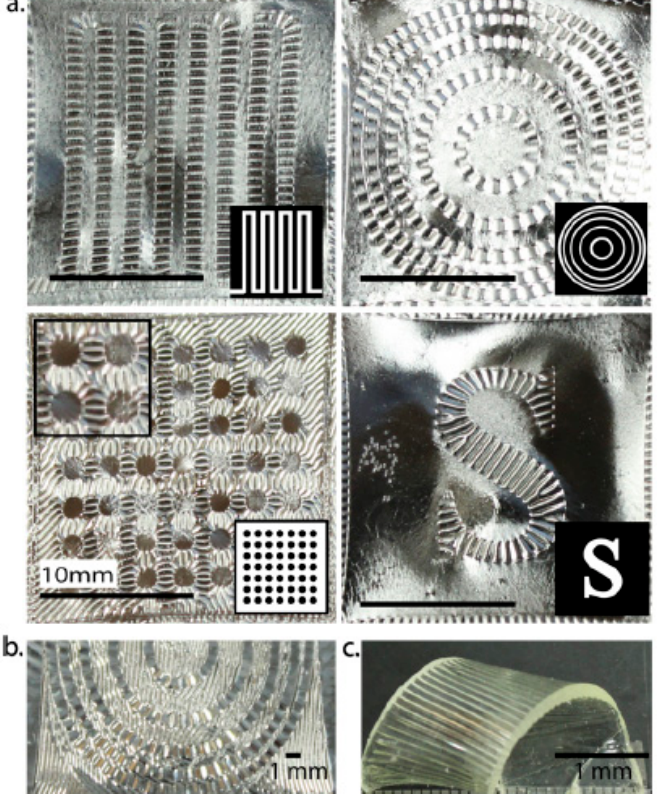
Figure 3. Wrinkle formation via photopatterning on a biaxially stretched specimen. ( a ) Photolithography guides the alignment of the wrinkles perpendicular to the low stress regions of the thiol − ene elastomer (inset: corresponding photomasks). ( b ) Photopolymerized sample showing alternating wrinkle wavelengths, created by stepwise dosing ( c ) Employing two different photoinitiators allows for wrinkle formation and shape memory. Wrinkles were formed using a procedure similar to ( a ). Reprinted (adapted) with permission from [54]. Copyright: 2013, American Chemical Society.